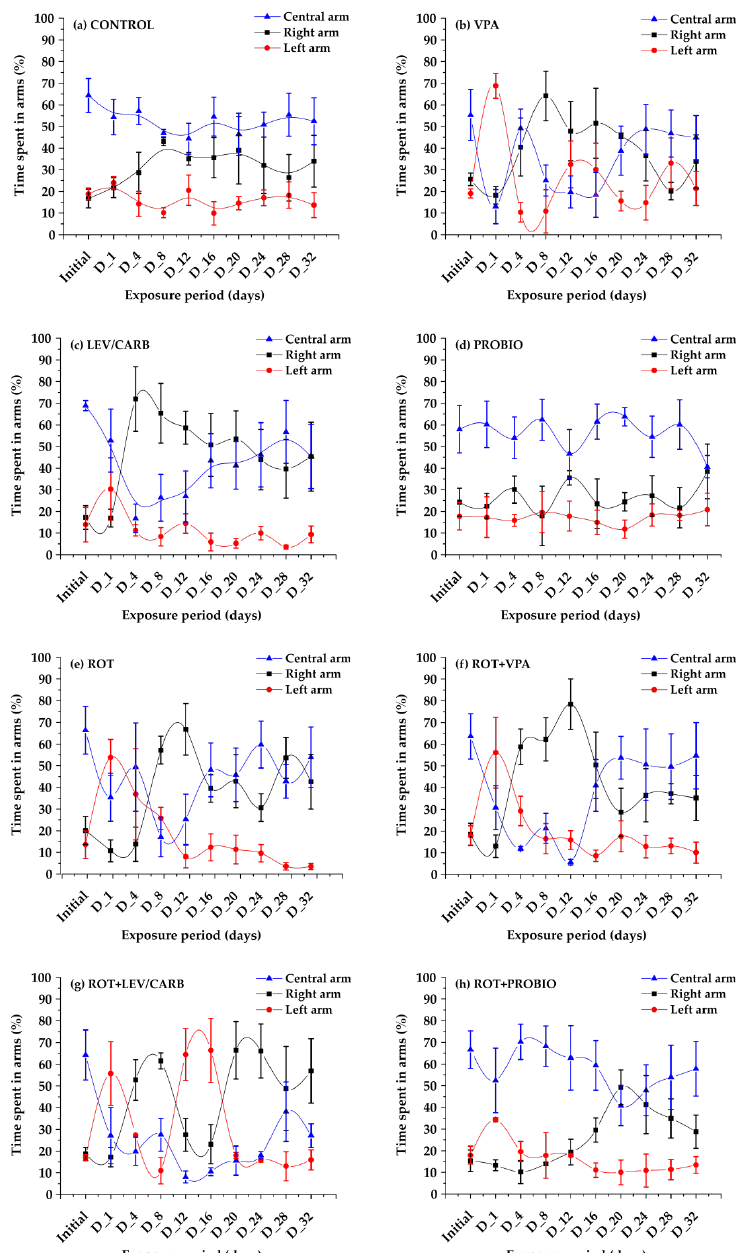
Figure 4. Aggressive-like patterns in Danio rerio (n = 5) studied groups and their tendencies toward all three arms (values expressed as mean with SEM followed by Dunnett’s test ).